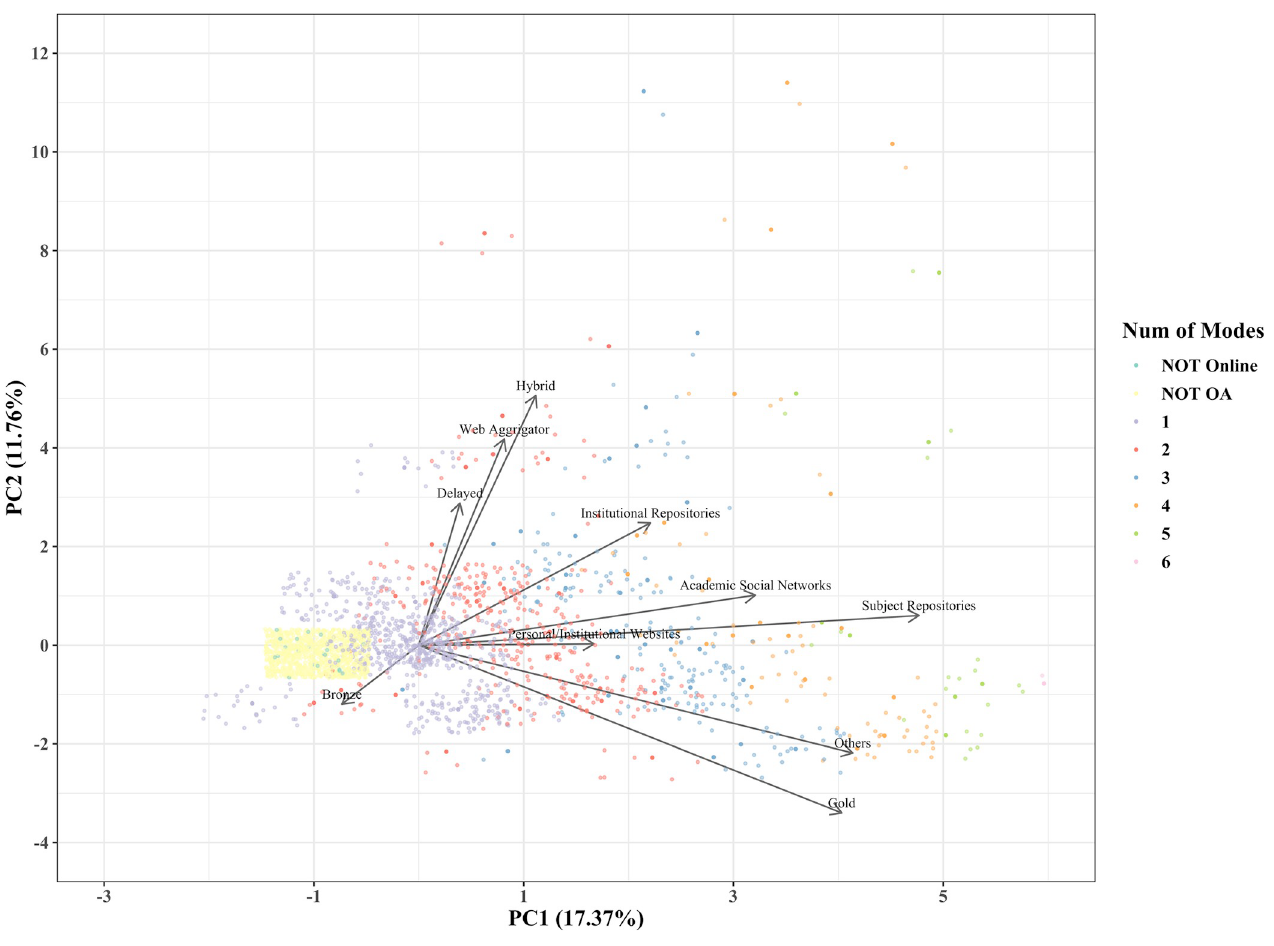
Fig 1. Principal component score plot